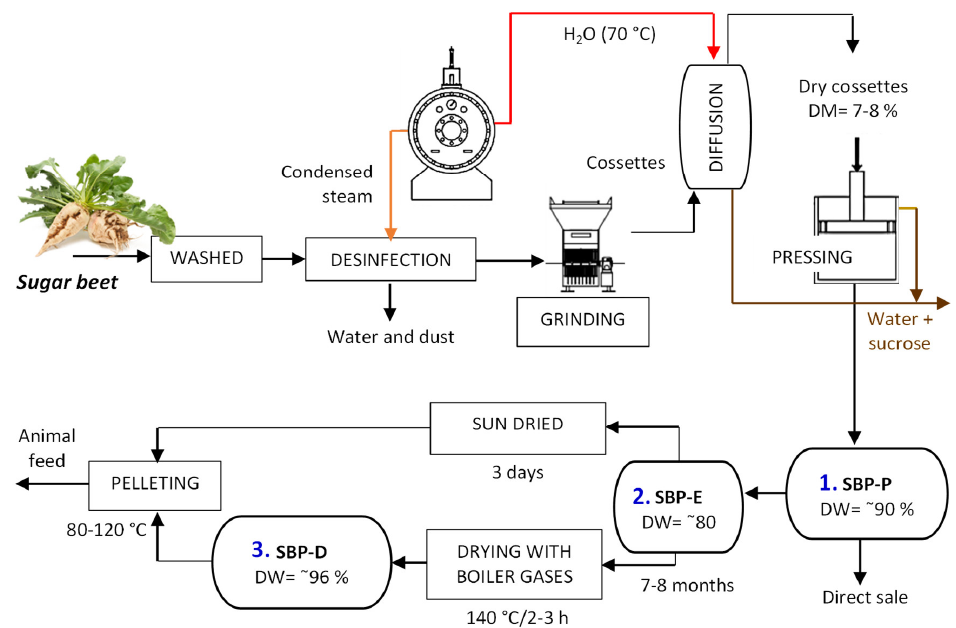
Figure 1. Industrial process of sugar extraction form sugar beet. By-products obtained: 1. SBP-P: sugar beet pulp pressed, 2. SBP-E: sugar beet pulp ensiled, 3. SBP-D: sugar beet pulp dried. DW: dry weight.